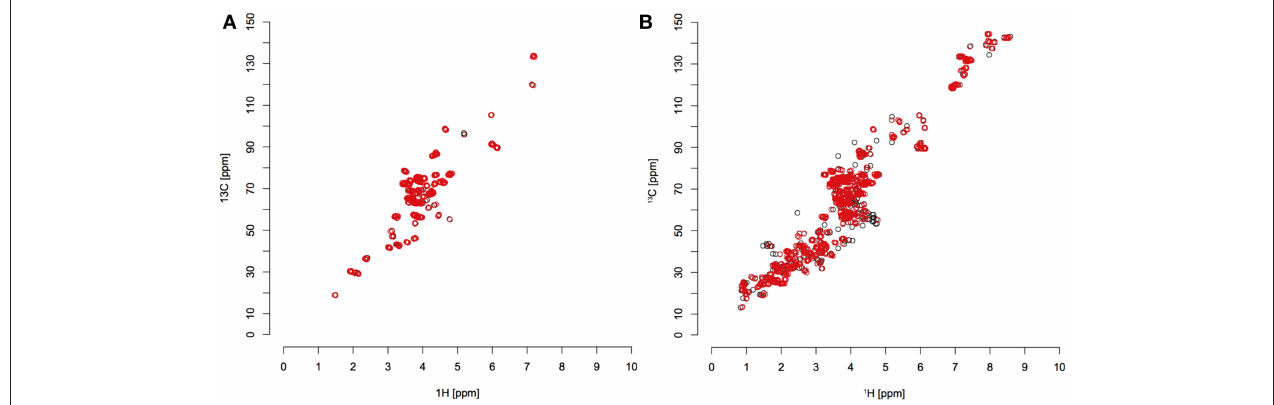
FIGURE 4 | Red circles indicate detected peaks that were matched to reference compounds from the HMDB library; black circles indicate detected peaks that were not matched. (A) unlabeled C. elegans extract; (B) fully 13 C labeled C. elegans extract.